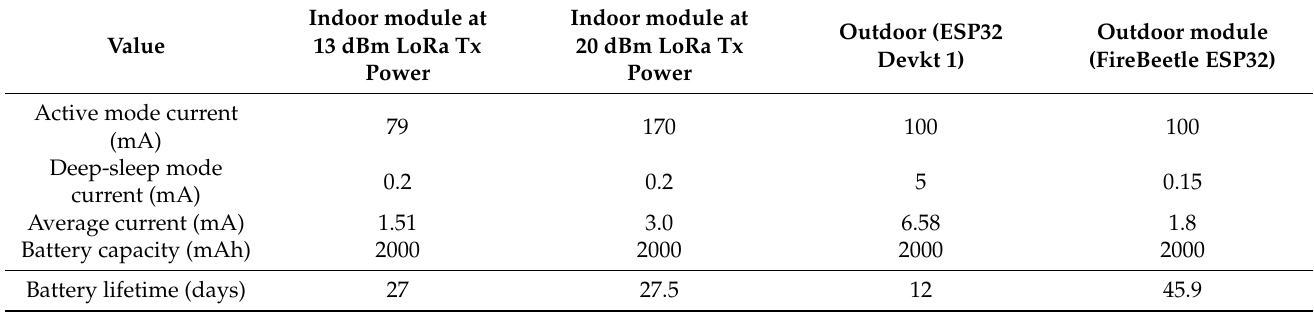
Table 2. Current consumption of the wireless modules and battery